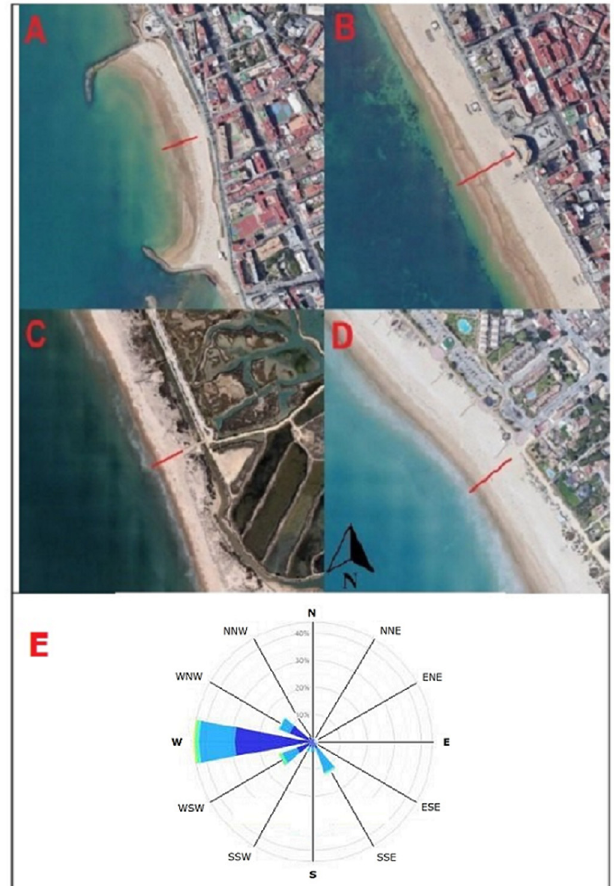
Figure 2. Location of the profiles monitored in the four different beaches: SMM ( A ), Victoria ( B ), Camposoto ( C ), and Barrosa ( D ). A wind rose diagram ( E ) is also presented. The orientation of the beaches is approximately NNW in all of them.